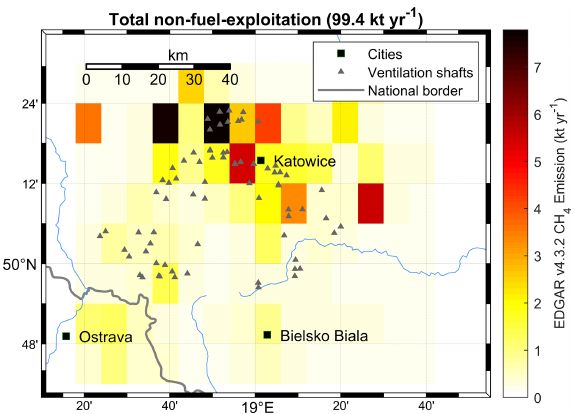
Figure 2. Total non-fuel-exploitation CH 4 emission from the EDGAR v4.3.2 emission inventory corresponding to the following five sectors: solid waste landfills, energy for buildings, waste water handling, enteric fermentation, and oil refineries and transformation